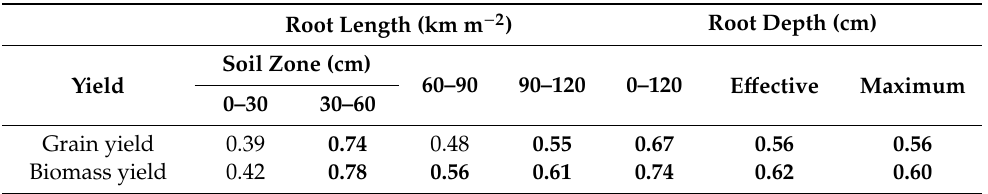
Table 5. Correlation between the average grain and biomass yields and root length, maximum depth, and e ff ective depth. Root Length (km m − 2